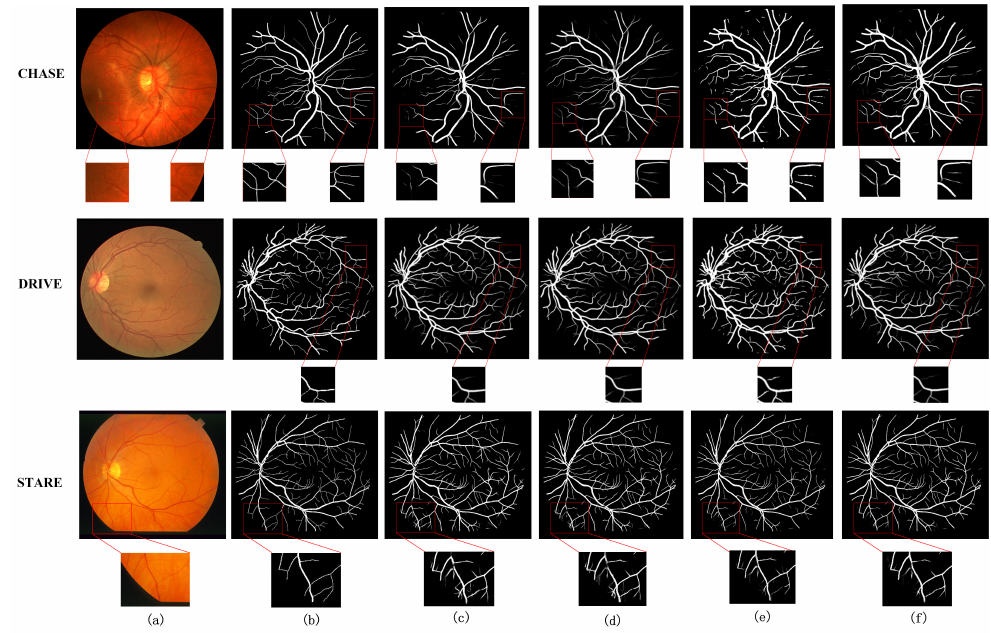
Figure 8. Visualization of ablation experiments on three datasets. ( a ) original image, ( b ) groundtruth image, ( c ) BaseLine, ( d ) BaseLine+SCI, ( e ) BaseLine+SCI+ MT, ( f )